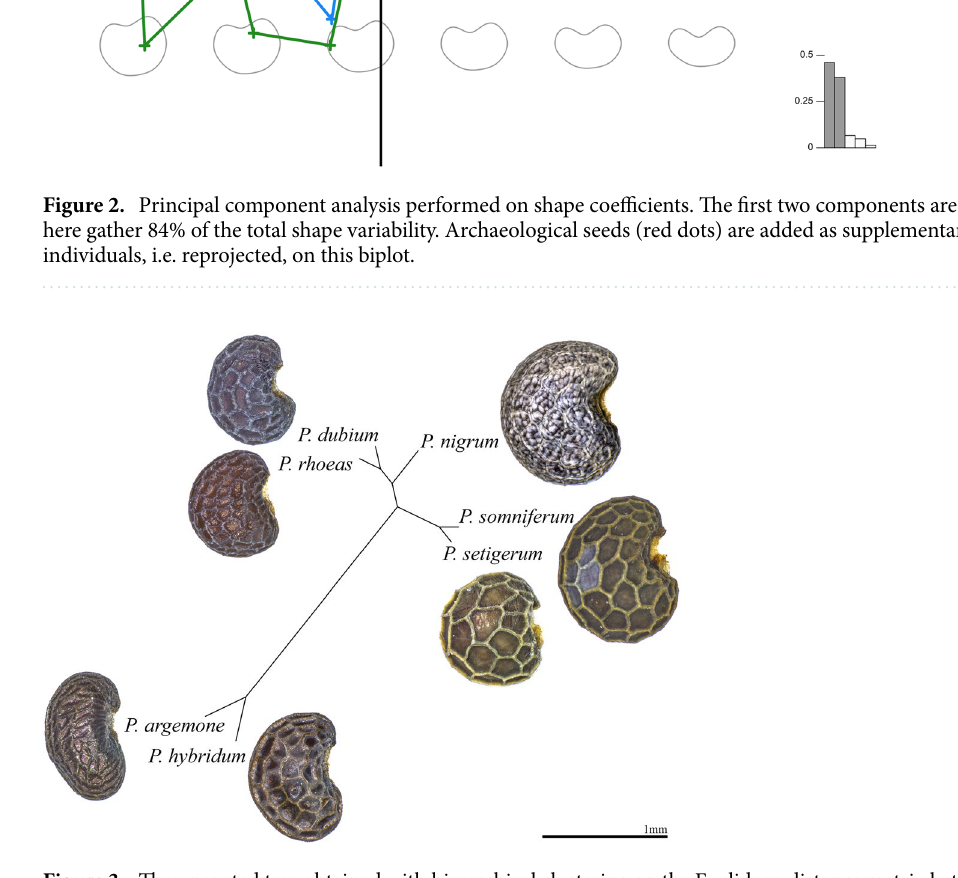
Figure 3. The unrooted tree obtained with hierarchical clustering on the Euclidean distance matrix between Fourier coefficients averaged per